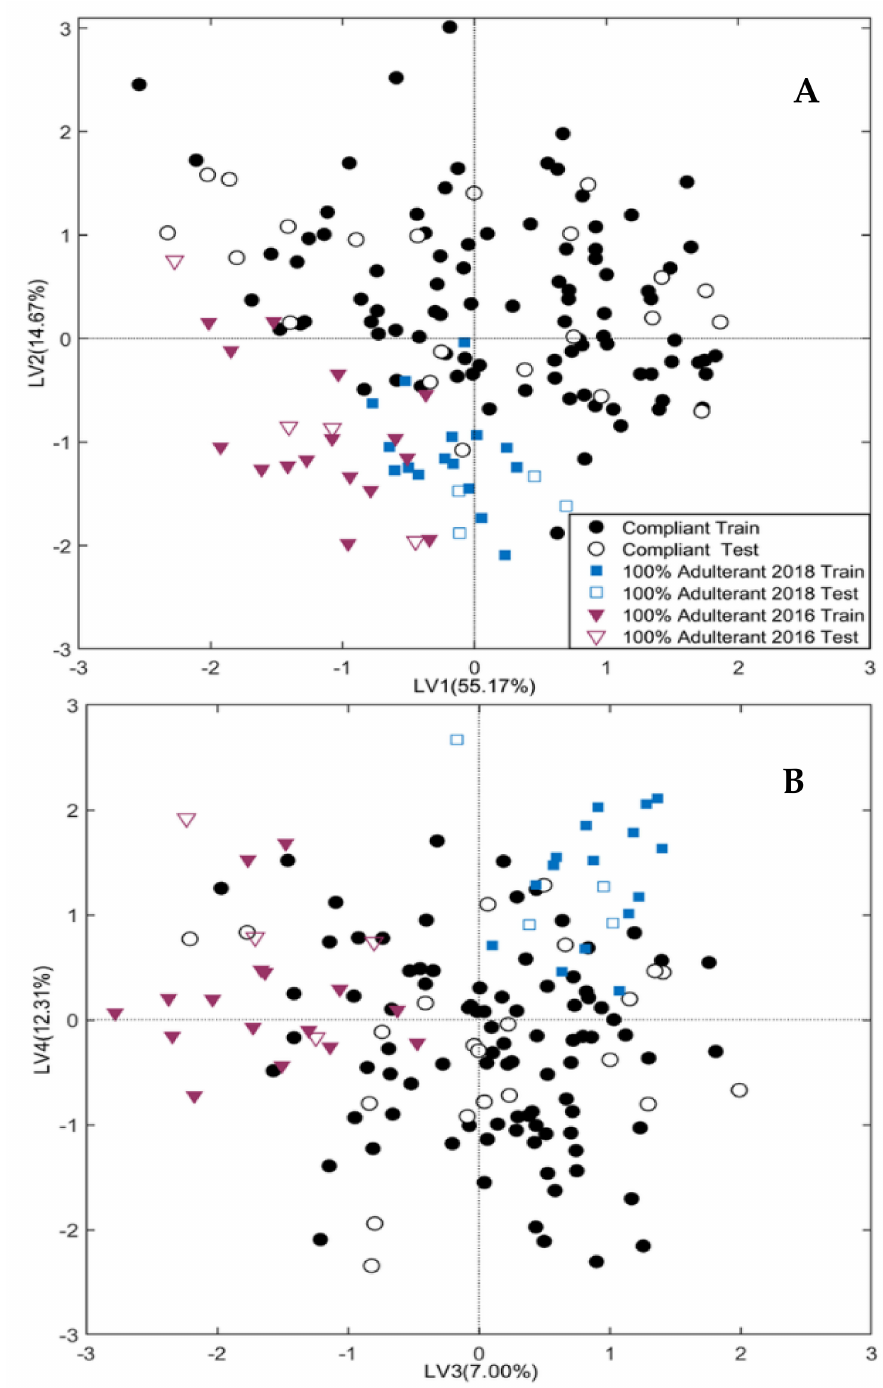
Figure 2. Sample scores onto the LV1-LV2 space ( A ) and LV3-LV4 space ( B ) for Model I, built on Compliant samples and Pure Adulterants (100% Adulterant 2018 and 100% Adulterant